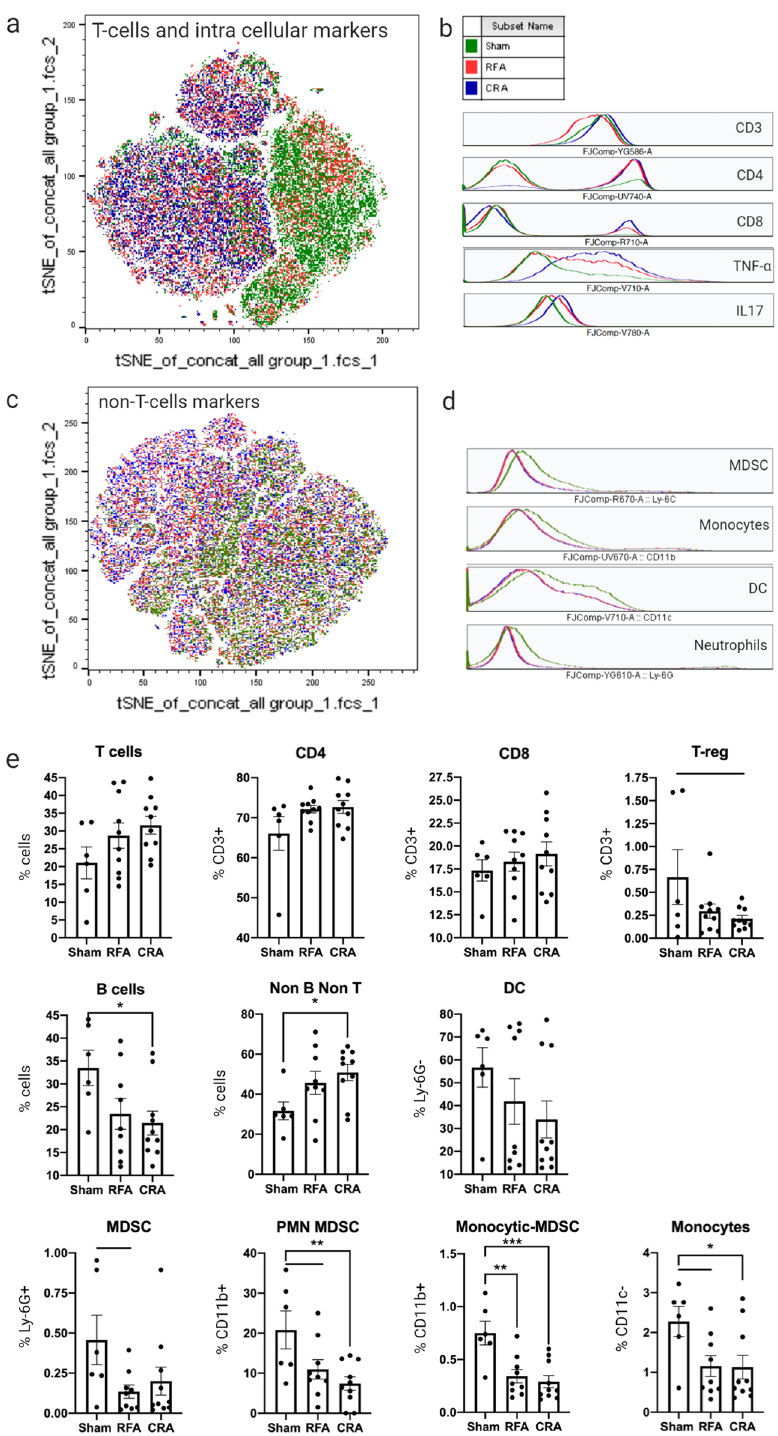
Figure 3. Flow cytometry analysis of splenocytes post ablation. ( a ) t-SNE plot of T-cells markers and ( b ) corresponding histograms. ( c ) t-SNE plot of non-T cell markers and ( d ) corresponding histograms. Treatment groups: sham (green), RFA (red), and CRA (blue). ( e ) Frequency of total T cells (CD3 + ), CD4 + , CD8 + , CD4 + T regulatory (CD4 + FOXP3 + ), B (CD3 − CD19 + ), non-B non-T (CD3- − CD19), DC (CD11c + ), MDSC (CD11b + Ly6G + ), PMN MDSC (CD11b + Ly6C + ), Monocytic MDSC (CD11b + Ly6G − + Ly6C + ), and monocytes (CD11c − Ly6C + ). Ordinary one-way ANOVA. The mean is represented by the box and whiskers reflect the standard error of the mean, *p < 0.05, **p < 0.01, ***p < 0.001. Group comparison without an asterisk represents a trend at p ≤ 0.07. Statistical analyses were performed using GraphPad Prism version